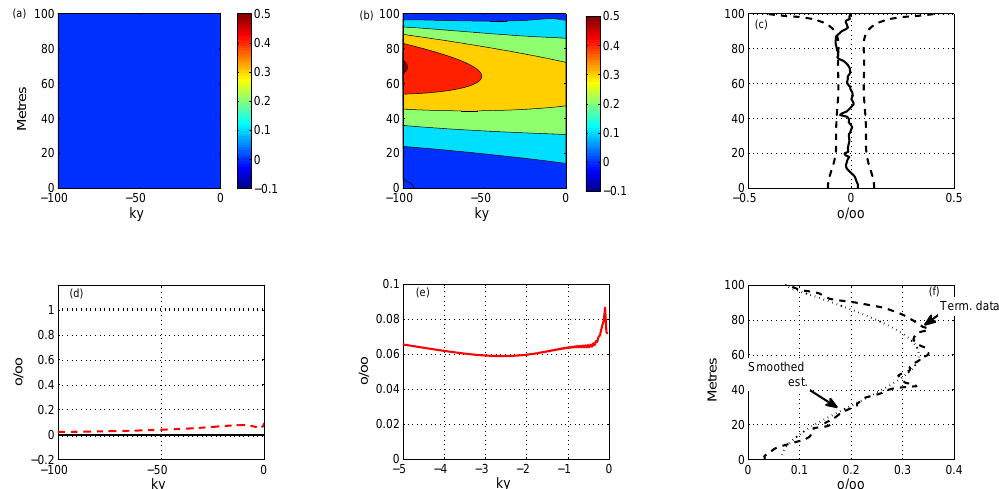
Figure 8. Same as Fig. 7 except that the initial condition was zero with a large uncertainty, rendering the Kalman filter solution zero until the very end when the terminal data are encountered so that the prediction is zero. The smoothed solution is very similar to that with a near-periodic initial condition, and the initial condition is roughly reconstructed.